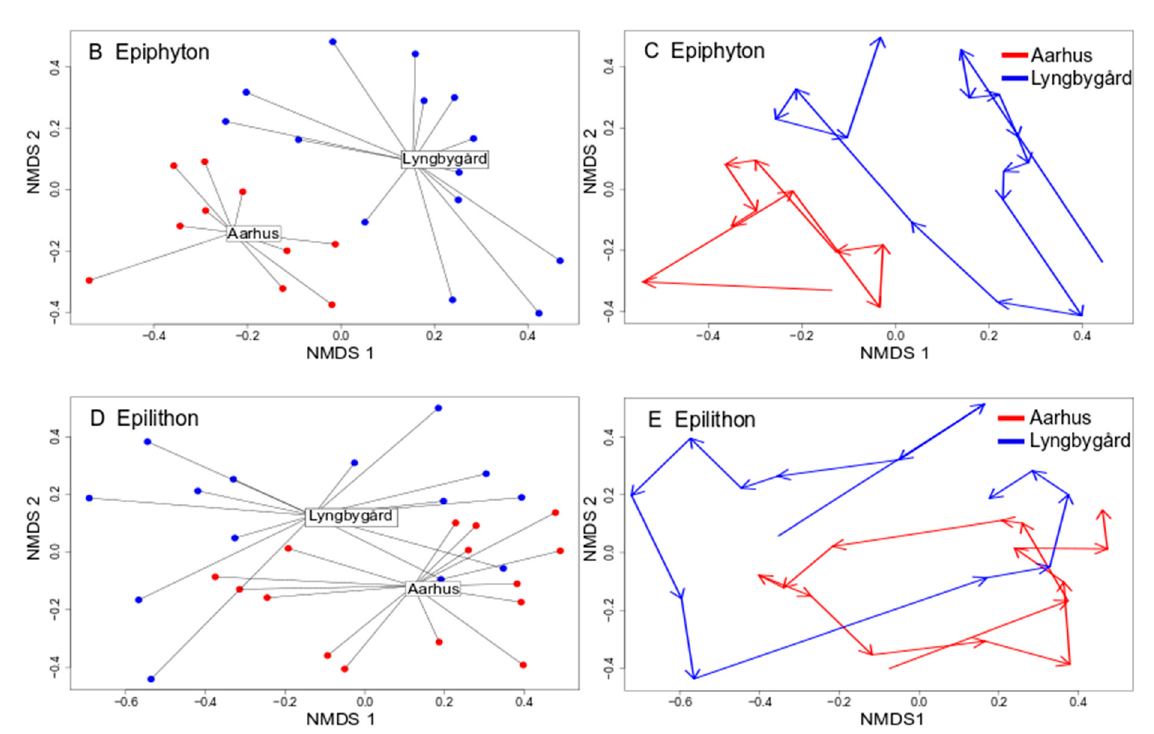
Figure 4. Differences in diatom species composition and trajectories of community change over the study year. ( A ): epi- phyton and epilithon diatom species composition; ( B ): epiphytic diatom communities in two streams; ( C ): trajectories of epiphytic community change over the study year; ( D ): epilithic diatom communities in two streams and ( E ): trajectories of epilithic community change over the year.